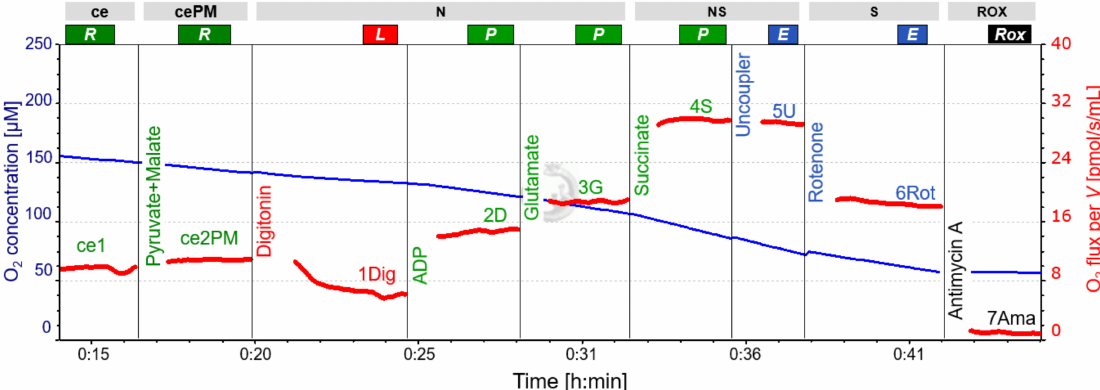
Figure 1. Representative respirometric trace following SUIT 8 protocol. Blue line: O 2 concentration, measured at 2-second time intervals, showing the decline over time and the effect of oxygen added with titrations (particularly with substances dissolved in ethanol containing a high concentration of O 2 ; see CCCP and rotenone titrations). Oxygen concentration